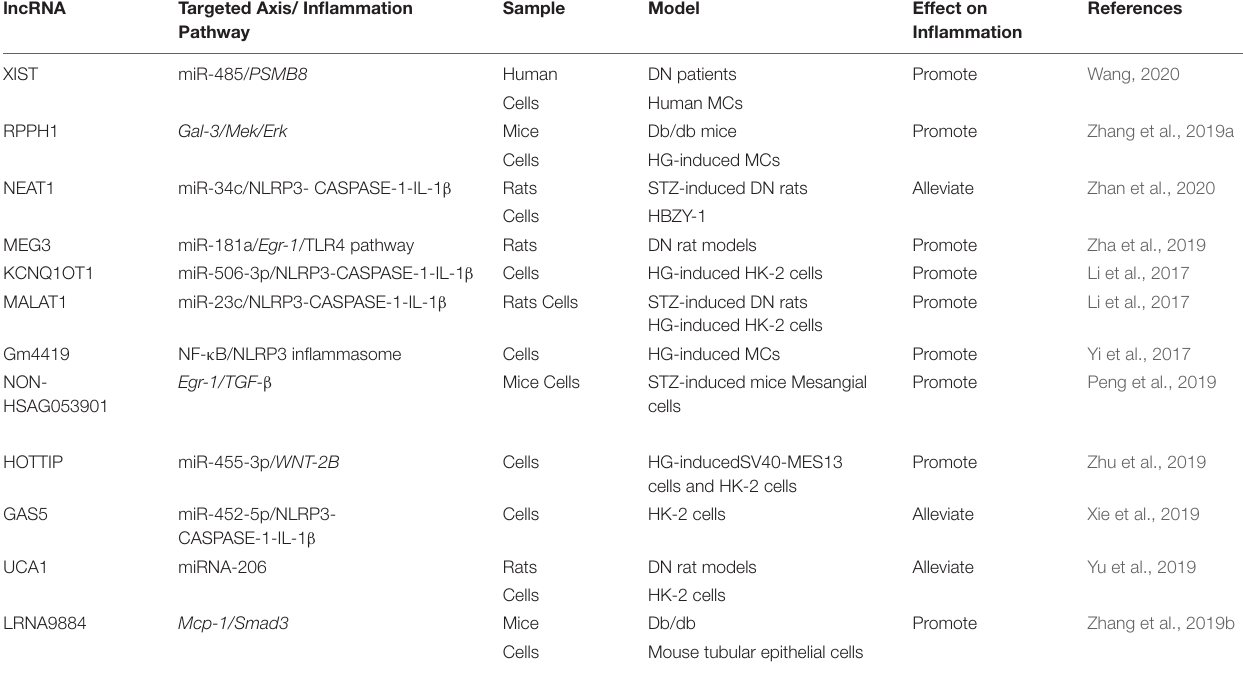
TABLE 2 | The target genes and potential mechanisms of lncRNAs associated with inflammation in DN. lncRNA